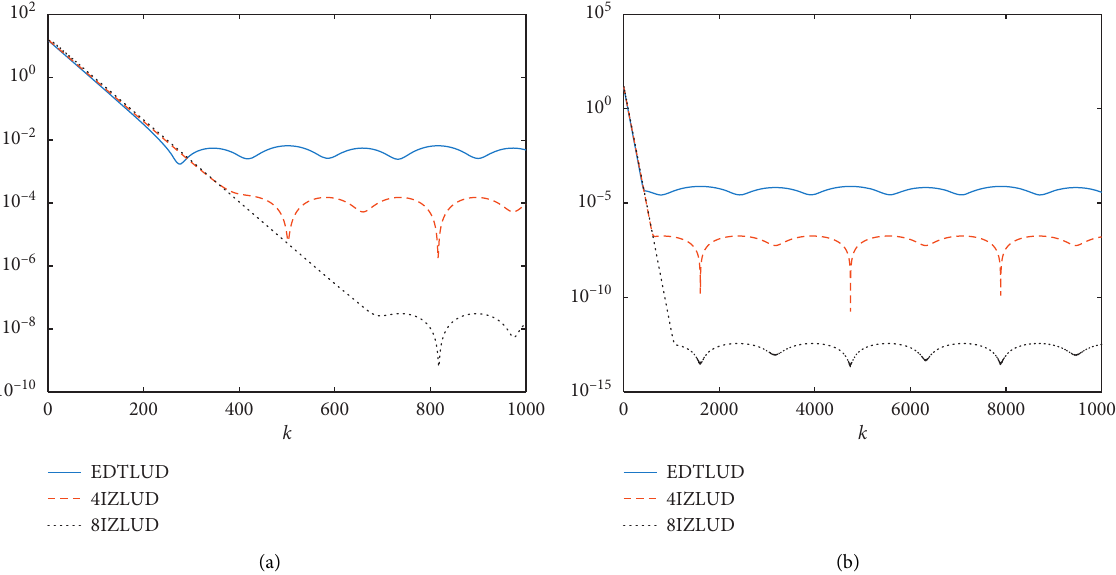
Figure 5: Residual errors of three discrete-time models with g � 0 . 03 and s ( 0 ) � 2 1 2 3 􏼂 􏼃 T for solving 2-dimensional time-varying LU decomposition problem in Example 1. (a) When η � 0 . 01 s. (b) When η � 0 . 001